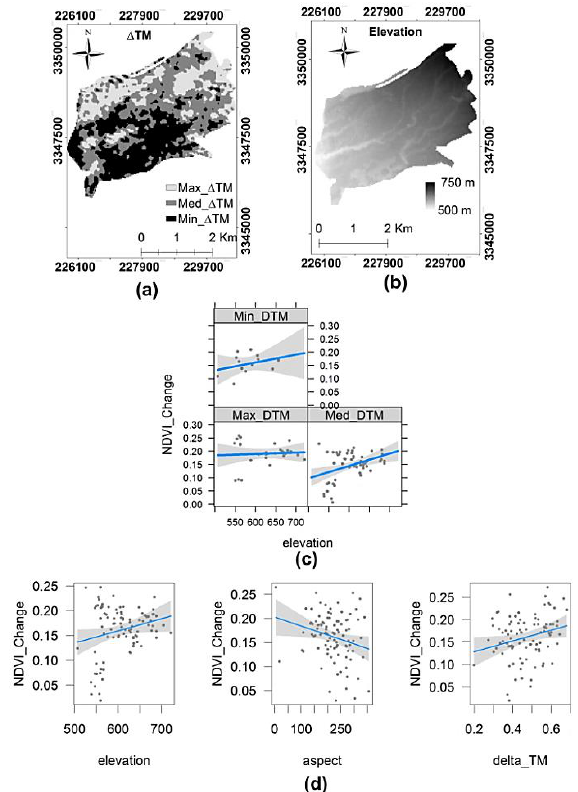
Figure 5: Graphical representation of outputs between Nov 2013 to Apr 2014. (a) ∆TM map representing variation in Max_∆TM (maximum change in LST), Med_∆TM (medium change in LST) and Min_∆TM (minimum change in LST) categories (b) Elevation map representing variation in topography (c) Cross sectional plots of the NDVI change model with an intraction between elevation and ∆TM with emphasis on elevation (d) Univariate relationship of NDVI change with elevation, aspect and ∆TM. Furthermore, estimated univariate association of NDVI change with elevation, aspect and ∆TM are shown in figure 5 (d). The figure 5 (a) also represents the interaction among elevation and ∆TM for NDVI change . Among the ∆TM range, higher association between elevation and NDVI change was observed within medium and minimum ∆TM